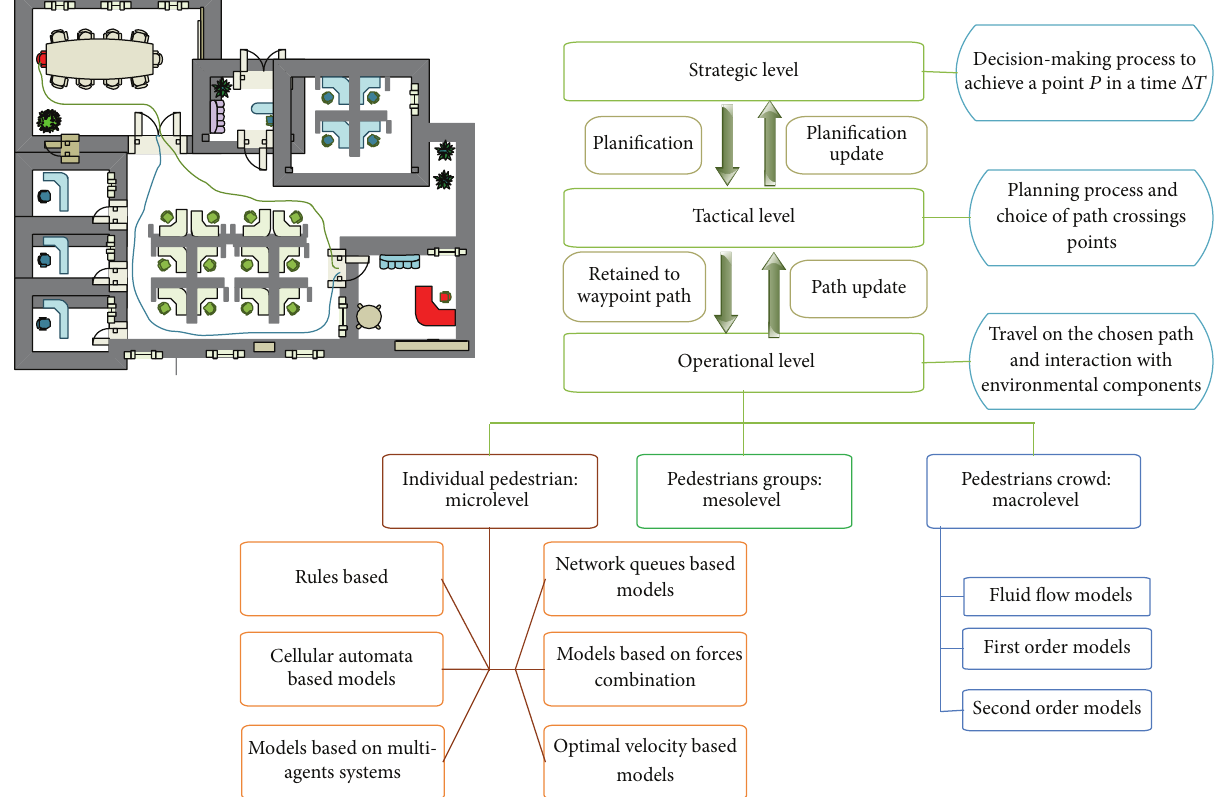
Figure 1: Decomposition of virtual pedestrians’